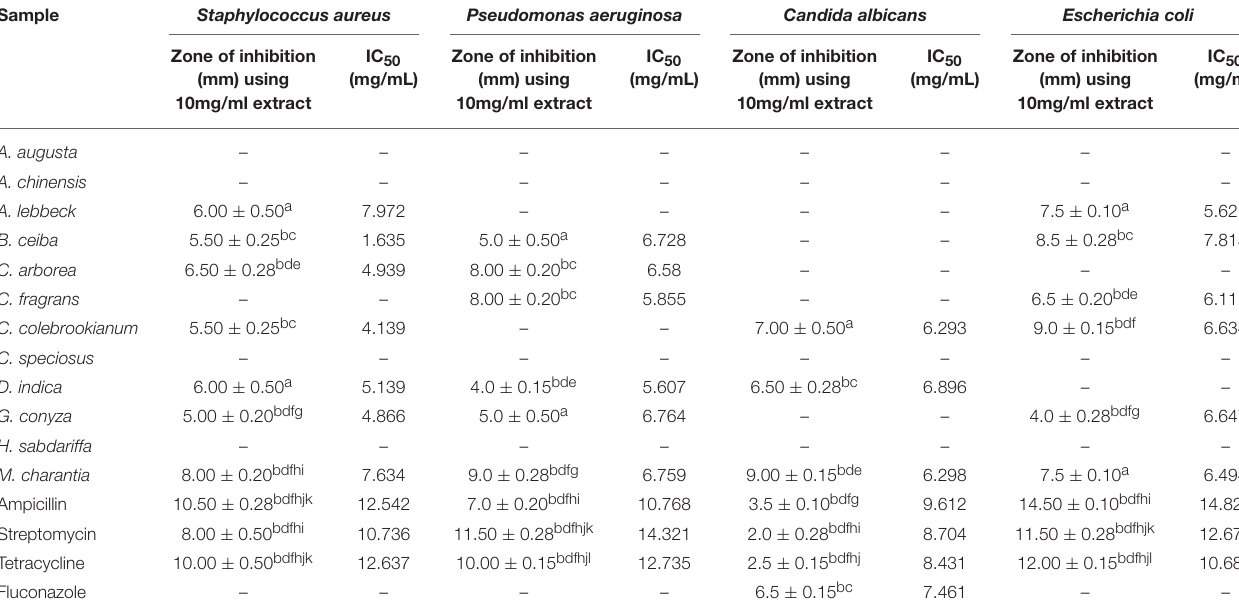
TABLE 4 | Well diffusion assay of antimicrobial activity of the selected medicinal plant extracts. Sample